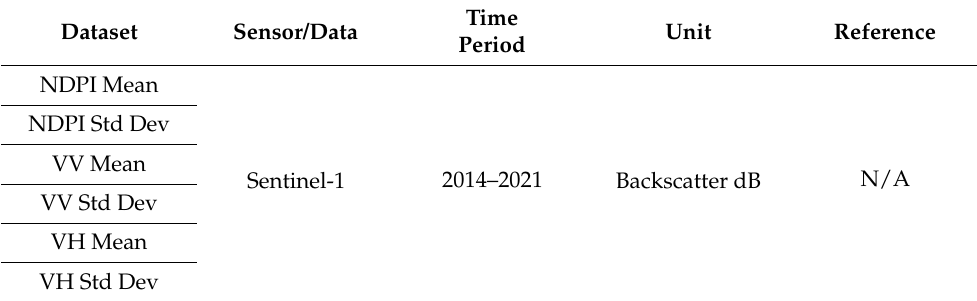
were produced in Google Earth Engine [49] and exported as GeoTiff files for local